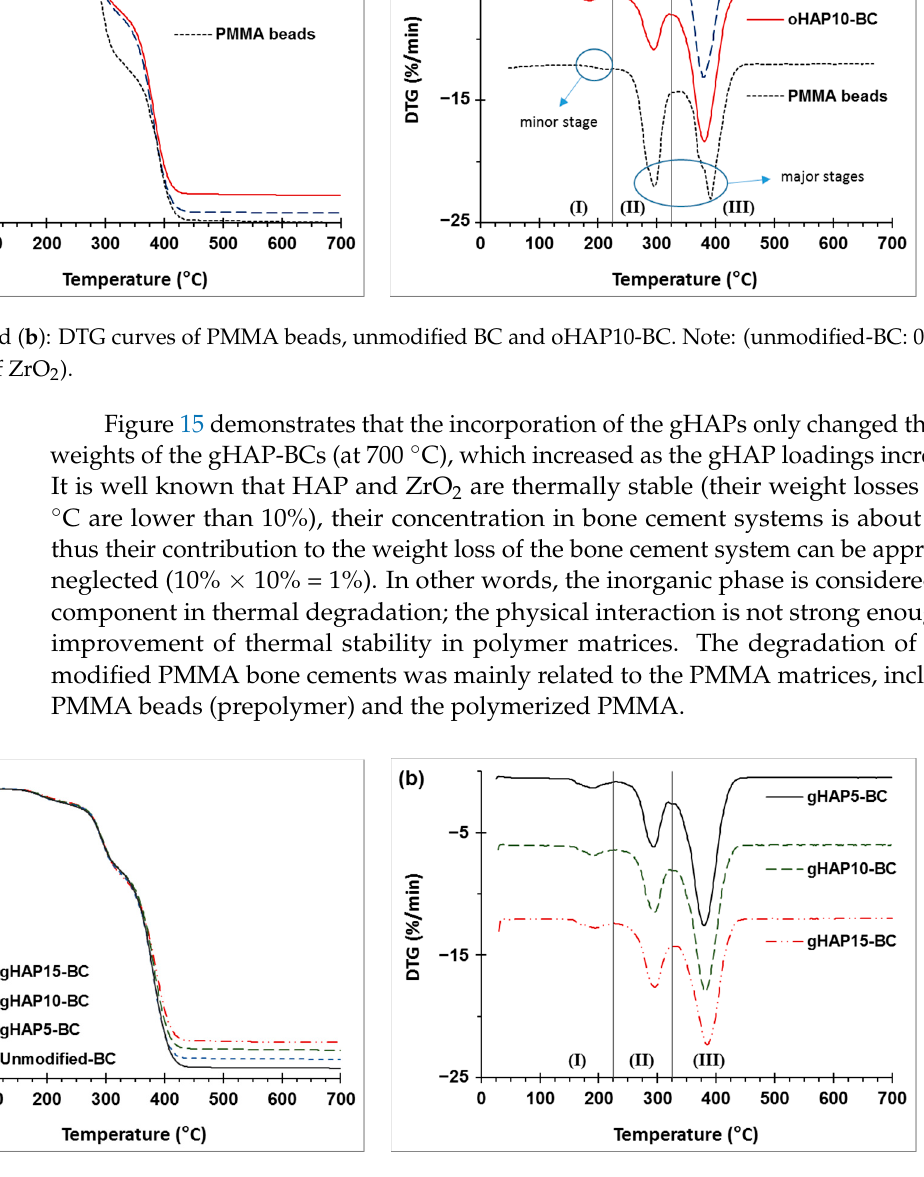
Table 4. TGA results of unmodified bone cement and HAP-modified bone cements.